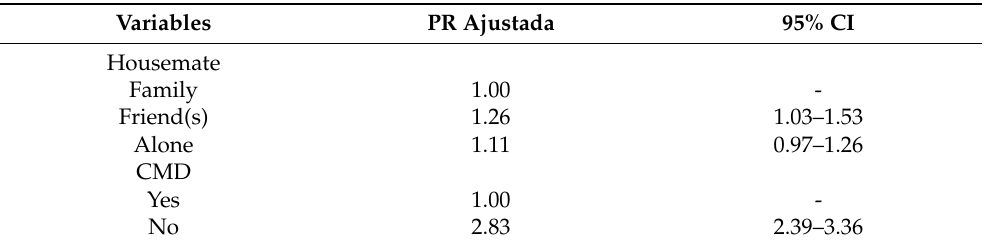
Table 3. Multivariate model of factors associated with the interaction of low self-compassion and high perceived stress in Brazilian men. Brazil, 2020.